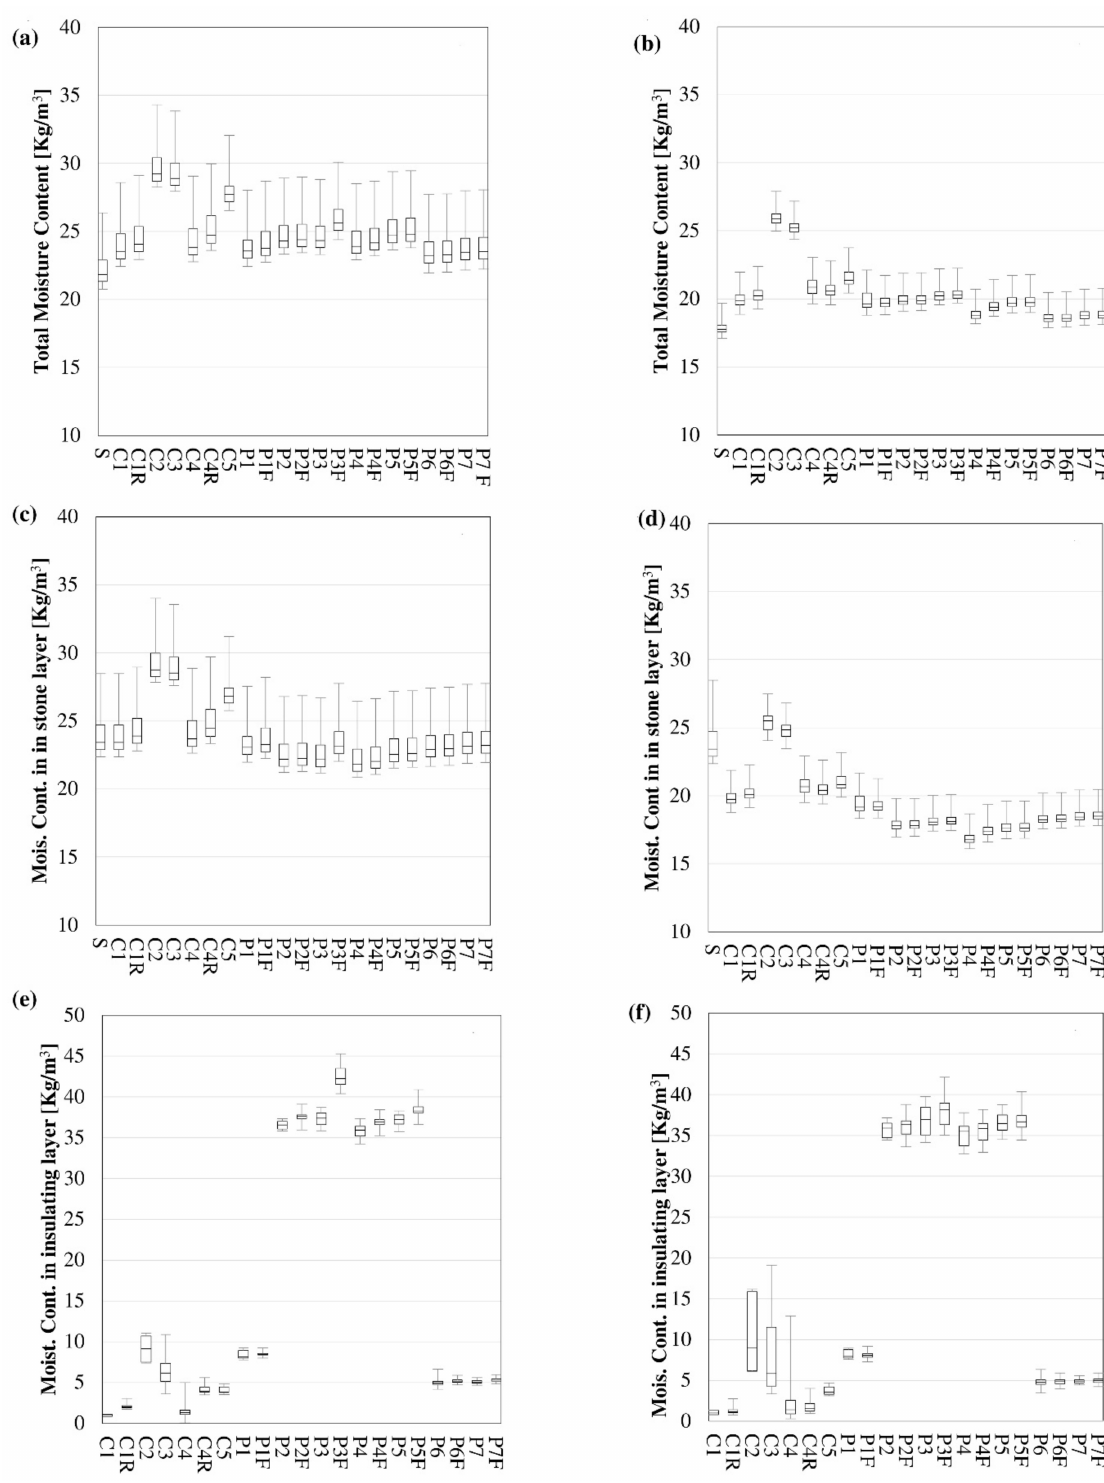
Figure 6. Box plots: Moisture Content of the overall configurations ( a ) in Monfero and ( b ) in Turin; Moisture Content of the stone layer ( c ) in Monfero and in ( d ) Turin; Moisture content of the insulating layer in Monfero ( e ) and Turin ( f